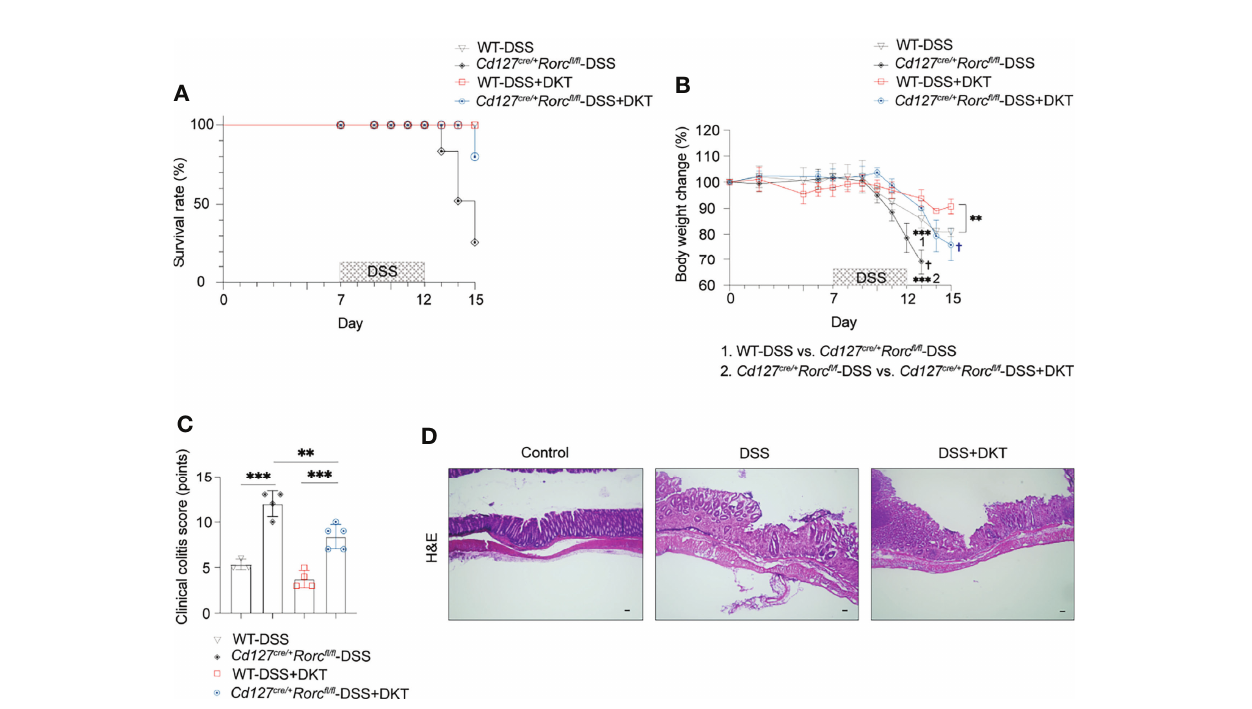
FIGURE 5 | ILC3 knockout (KO) leads to a high fatality rate from DSS-induced colitis that could be partially blunted by DKT. (A) Cd127 cre/+ Rorc fl / fl mice, or ILC3 KO mice and their corresponding Cd127 +/+ Rorc fl / fl , or wildtype (WT) littermates underwent DSS treatment as described in Figure 1A . The survival rate for the four experimental groups is shown (WT-DSS N=3, Cd127 cre/+ Rorc fl / fl -DSS N=4, WT-DSS+DKT N=4, Cd127 cre/+ Rorc fl / fl -DSS+DKT N=5). (B) Body weight changes of the four experimental groups (WT-DSS N=3, Cd127 cre/+ Rorc fl / fl -DSS N=4, WT-DSS+DKT N=4, Cd127 cre/+ Rorc fl / fl -DSS+DKT N=5). “ 1 ” refers to the signi fi cantly lower body weight in the ILC3 KO mice compared to their WT littermates after DSS treatment on day 13. “ 2 ” indicates that the body weight of the DSS-treated ILC3 KO mice was signi fi cantly lower relative to the ILC3 KO mice treated with DSS+DKT on day 13. † indicates death of the mice. (C) Clinical colitis scoring of the four experimental groups on day 13 (WT-DSS N=3, Cd127 cre/+ Rorc fl / fl -DSS N=4, WT-DSS+DKT N=4, Cd127 cre/+ Rorc fl / fl -DSS+DKT N=5). (D) Representative light micrographs of colon sections of the ILC3 KO mice on day 15 that stained with H&E (Control N=2, DSS N=1, DSS+DKT N=4). Scale bars, 100 m m. Each symbol in graph (C) represents data from an individual mouse. Graphs (B, C) show means ± SEM; **p<0.01, and ***p<0.001. Statistical analysis was performed using One- way ANOVA with Tukey ’ s multiple comparisons